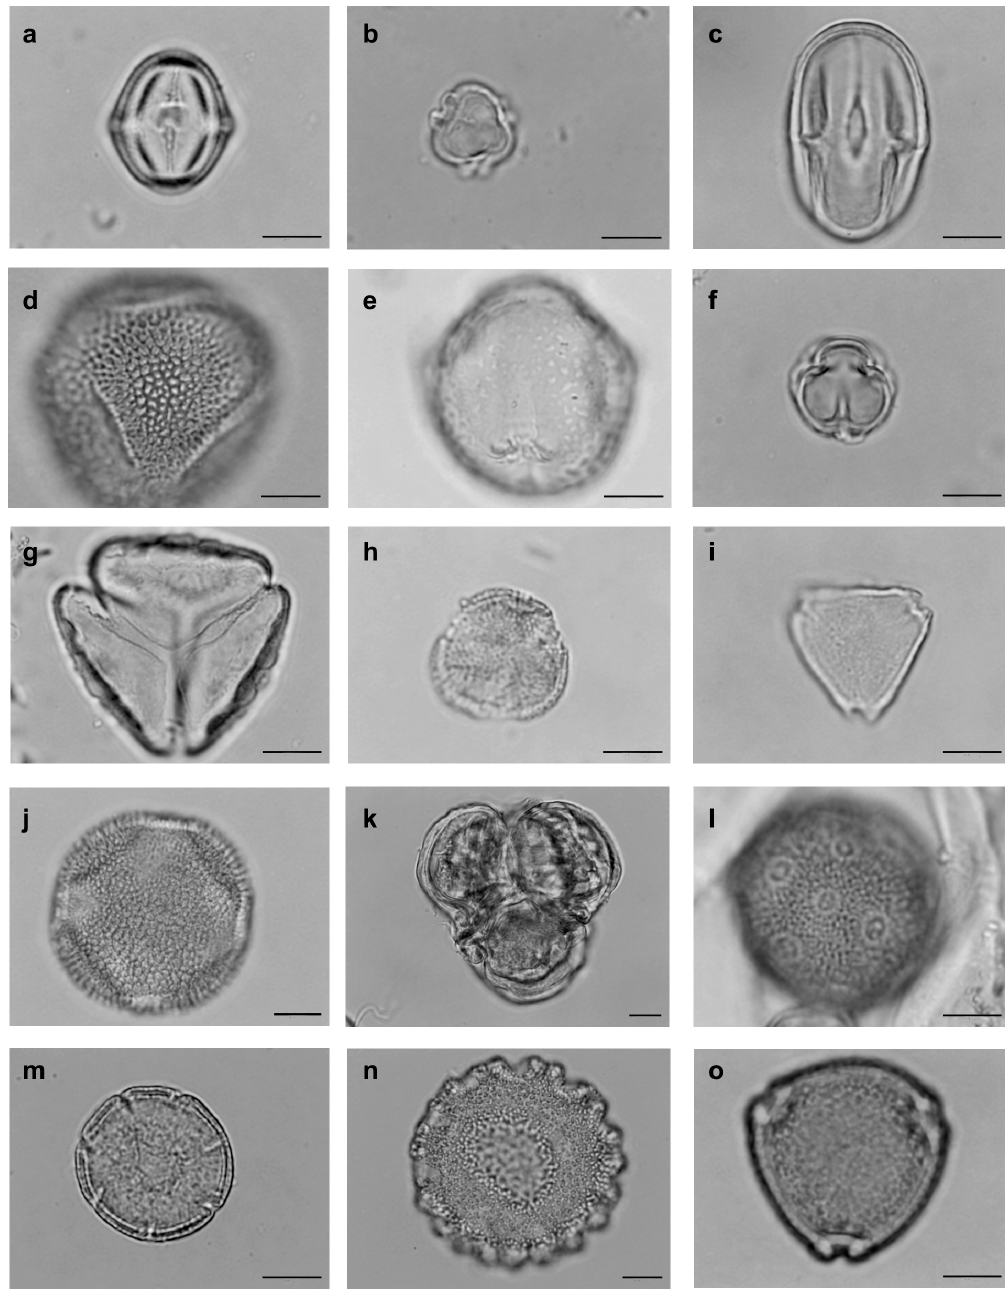
Figure 2. Pollen types from floral visiting bees’ bodies of Solanum dydimum at Araucarias Municipal Park in Guarapuava, Paraná state, Brazil. ( a – o ) Angiosperms, Eudicotyledons. ( a ) Fabaceae, Dalbergia . ( b ) Fabaceae, Platymiscium . ( c ) Fabaceae, Senna . ( d ) Fabaceae, Senna 2. ( e ) Fabaceae, Sesbania . ( f ) Fabaceae, Stylosanthes . ( g ) Loranthaceae, Struthanthus . ( h ) Menispermaceae. ( i ) Myrtaceae, Myrcia . ( j ) Nyctaginaceae, Neea . ( k ) Onagraceae, Ludwigia . ( l ) Phytolaccaceae. ( m ) Rubiaceae, Borreria . ( n ) Rubiaceae, Diodia . ( o ) Rubiaceae, Guettarda . (bar = 10 µm).